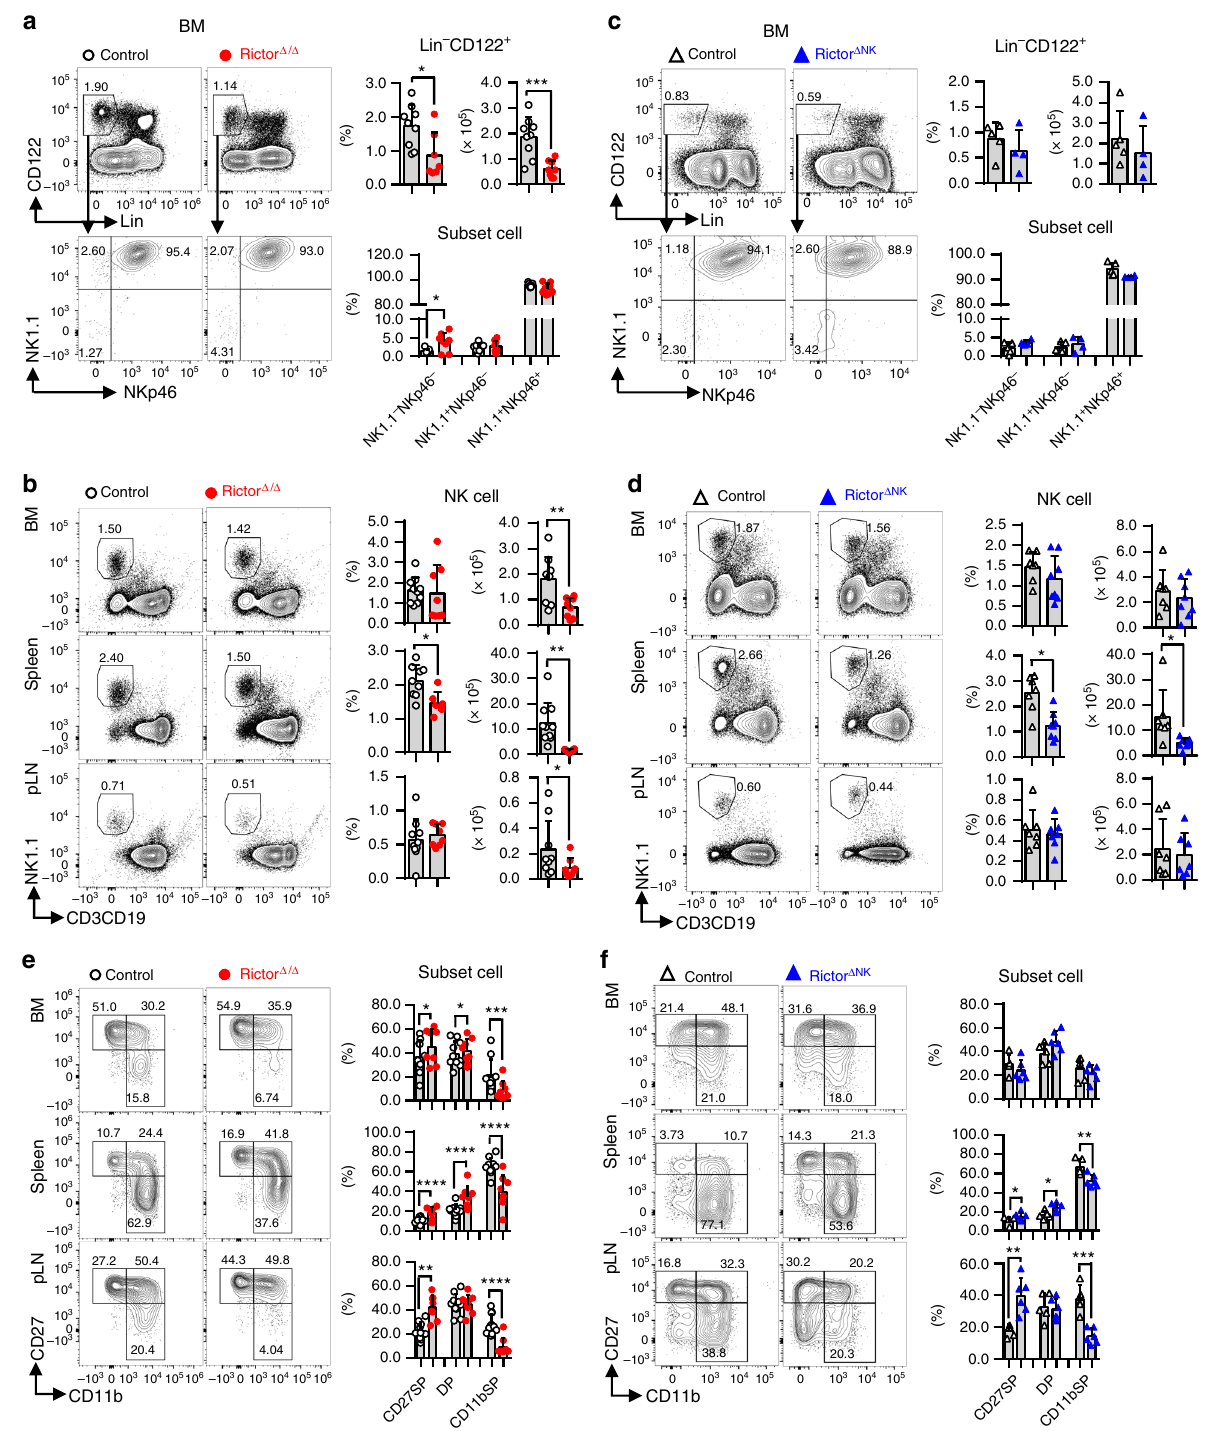
Fig. 1 Inhibition of mTORC2 activity results in impaired NK cell speci fi cation and maturation. a , c Flow cytometric analysis and enumeration of Lin − CD122 + (Lin: CD3, CD19, Ter119, Gr1) BM cells (top) and percentage of Lin − CD122 + BM cells expressing NK1.1 and/or NKp46 (bottom) from control ( Rictor fl / fl / Vav1 -Cre − ) versus Rictor Δ / Δ ( Rictor fl / fl / Vav1 -Cre + ) ( a ) or control ( Rictor fl / + / Ncr1 -Cre + ) versus Rictor Δ NK ( Rictor fl / fl / Ncr1 -Cre + ) mice ( c ). b , d Flow cytometric analysis and enumeration of NK cells (CD3 − CD19 − NK1.1 + ) in BM, spleen, and peripheral lymph nodes (pLNs) from control versus Rictor Δ / Δ ( b ) or control versus Rictor Δ NK mice ( d ). e , f Flow cytometric analysis and cumulative frequencies of subpopulations of NK cells (CD3 − CD19 − NK1.1 + NKp46 + ) in the BM, spleen, and pLNs from control versus Rictor Δ / Δ ( e ) or control versus Rictor Δ NK ( f ) mice. CD27SP, DP, and CD11bSP represent CD27 + CD11b − , CD27 + CD11b + , and CD27 − CD11b + NK cell subsets, respectively. For the bar graphs, each dot represents one mouse, and all experiments were replicated 3 ( c ), 4 ( f ), or 5 ( a , b , d , e ) times; error bars represent SD; ∗ p < 0.05, ∗∗ p < 0.01, ∗∗∗ p < 0.001, and ∗∗∗∗ p < 0.0001; unpaired two-tailed Student ’ s t test with Welsh ’ s correction ( a – f